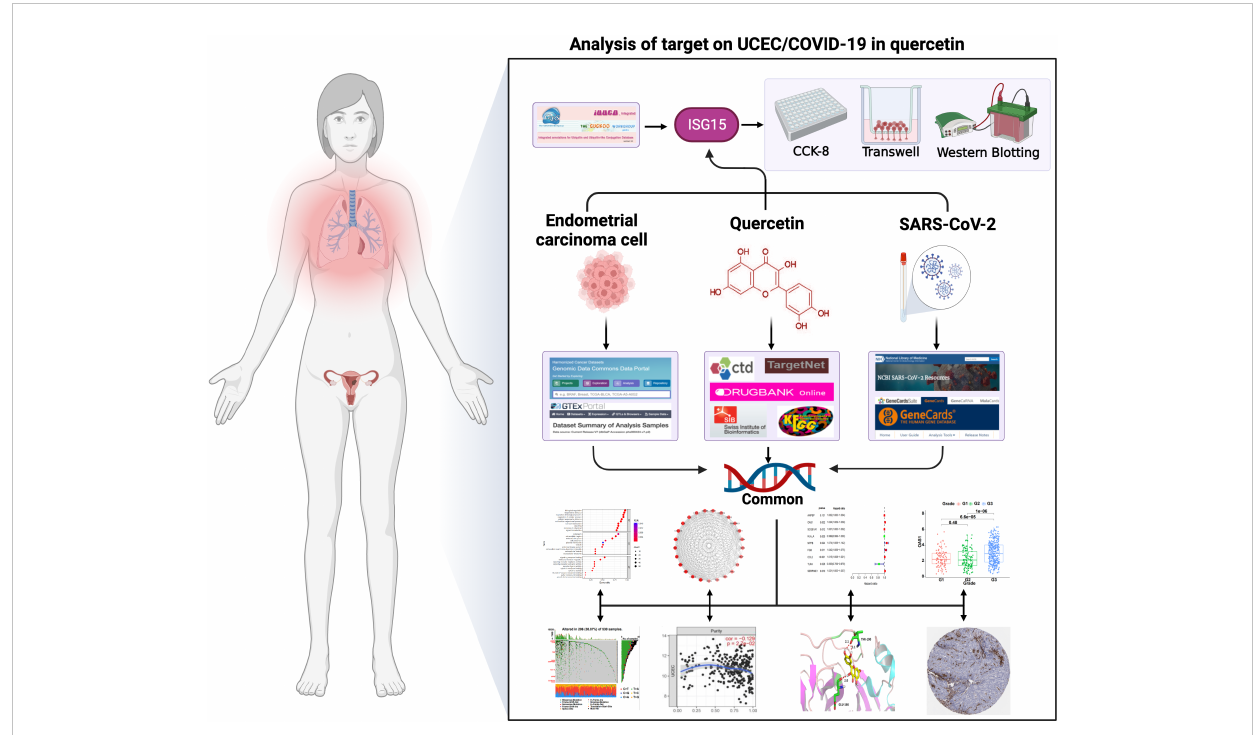
FIGURE 1 The graphical abstract of this article. The fi gure represents the antiviral action and mechanism of quercetin against UCEC/COVID-19 using the network pharmacology and computational bioinformatics analysis